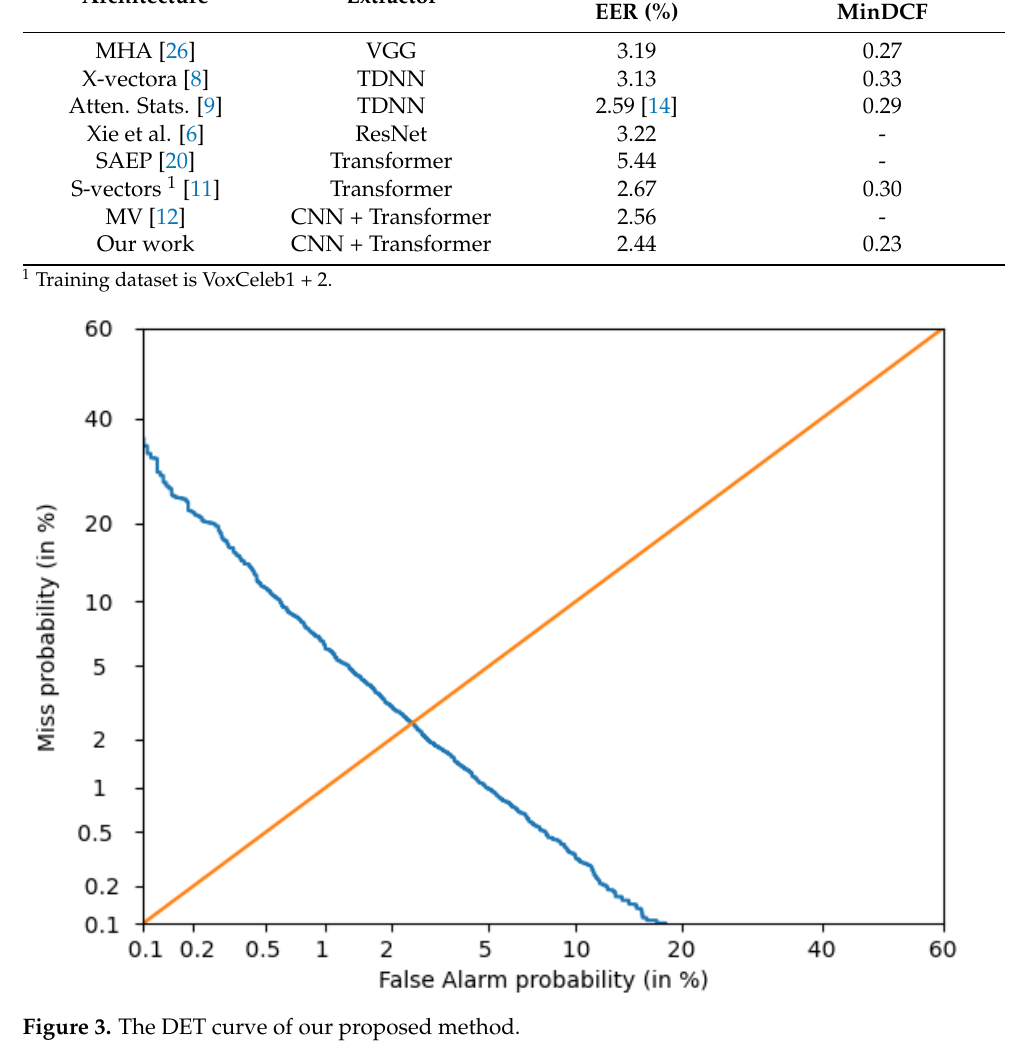
Table 2. The window size w changed from 15 to 30 frames.